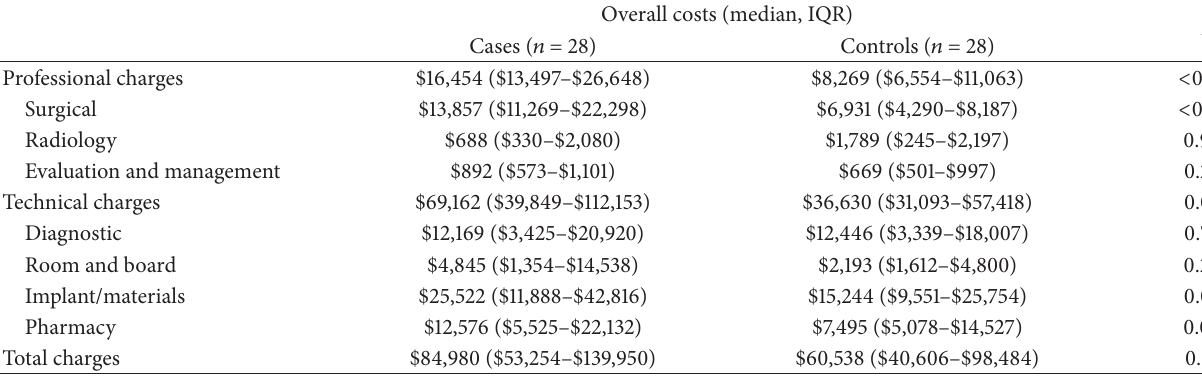
Table 2: Case versus control comparison for overall costs.